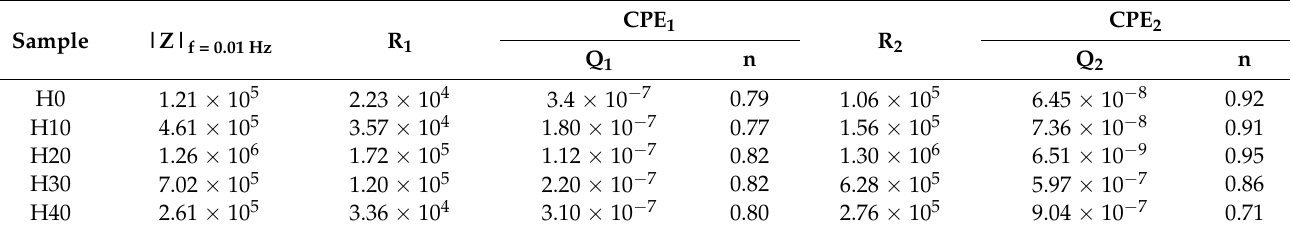
Table 5. Calculated parameters of equivalent electrical circuits (the units of R and |Z| f = 0.01 Hz are Ω × cm 2 ; Q are S × cm − 2 × s n ) for the coatings after 2 h immersion in 3.5 wt.% NaCl aqueous solution. |Z| f = 0.01 Hz was measured at the frequency f = 0.01 Hz.